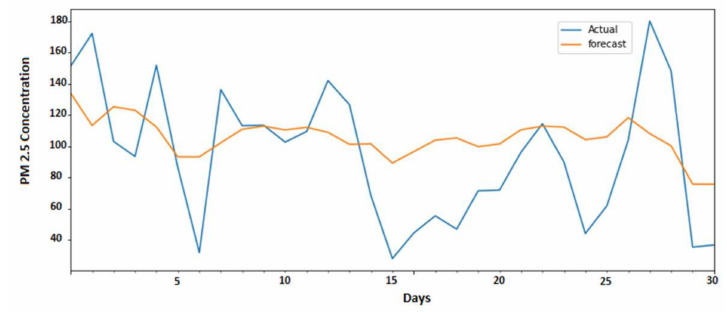
Figure 24. Forecasting for the next month for Karachi using the multivariate FbProphet model.